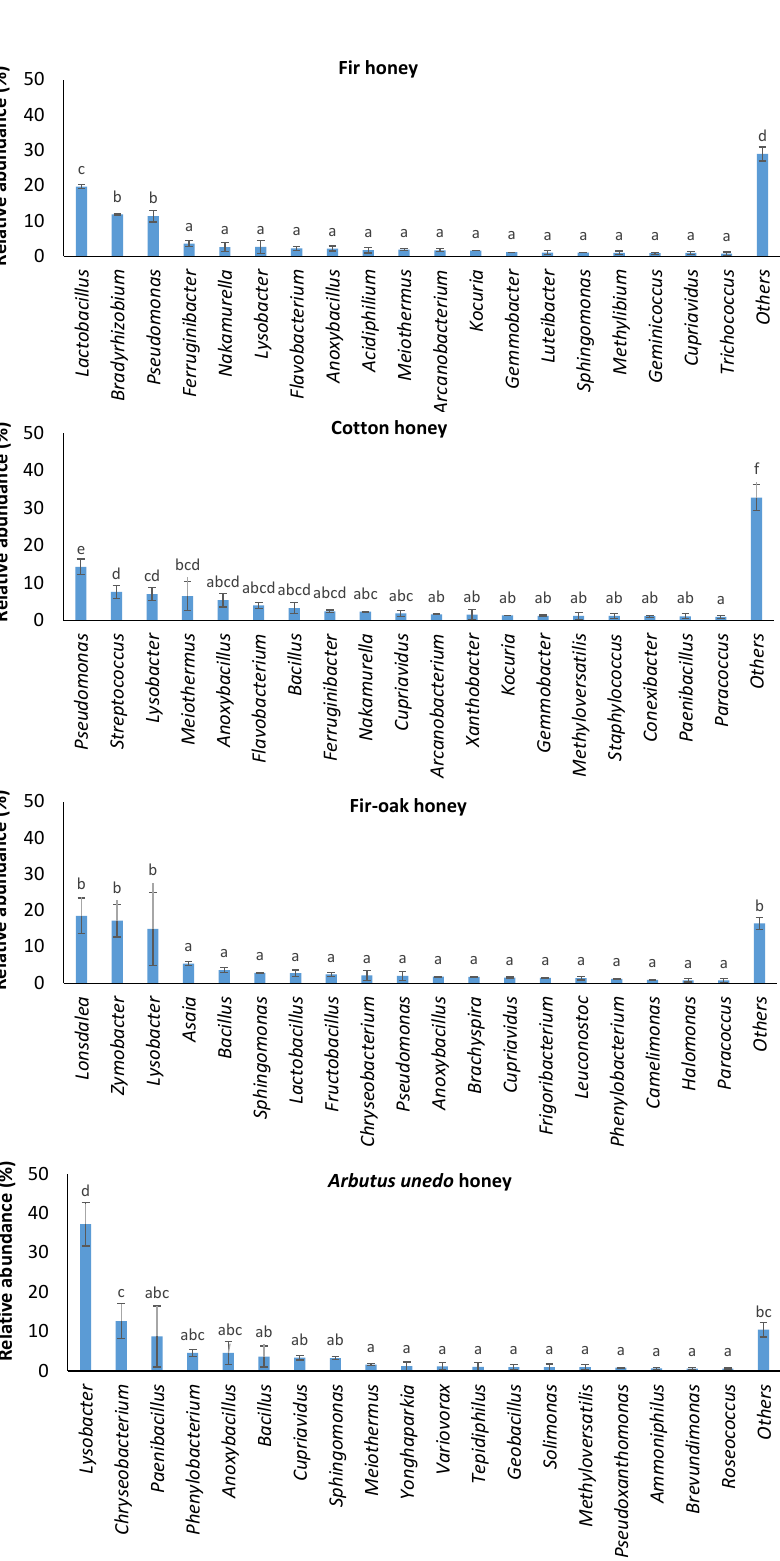
Figure 2. Major bacterial taxa identified in honey samples of different pollen origin. Bars represent ± standard errors of means. Analysis of variance (ANOVA) using Duncan ’ s multiple post hoc tests at a significance level of 5% ( a < 0.05 ) were carried out to identify statistically significant differences. No letter in common at the top of the bars is indicative of statistically significant differences.